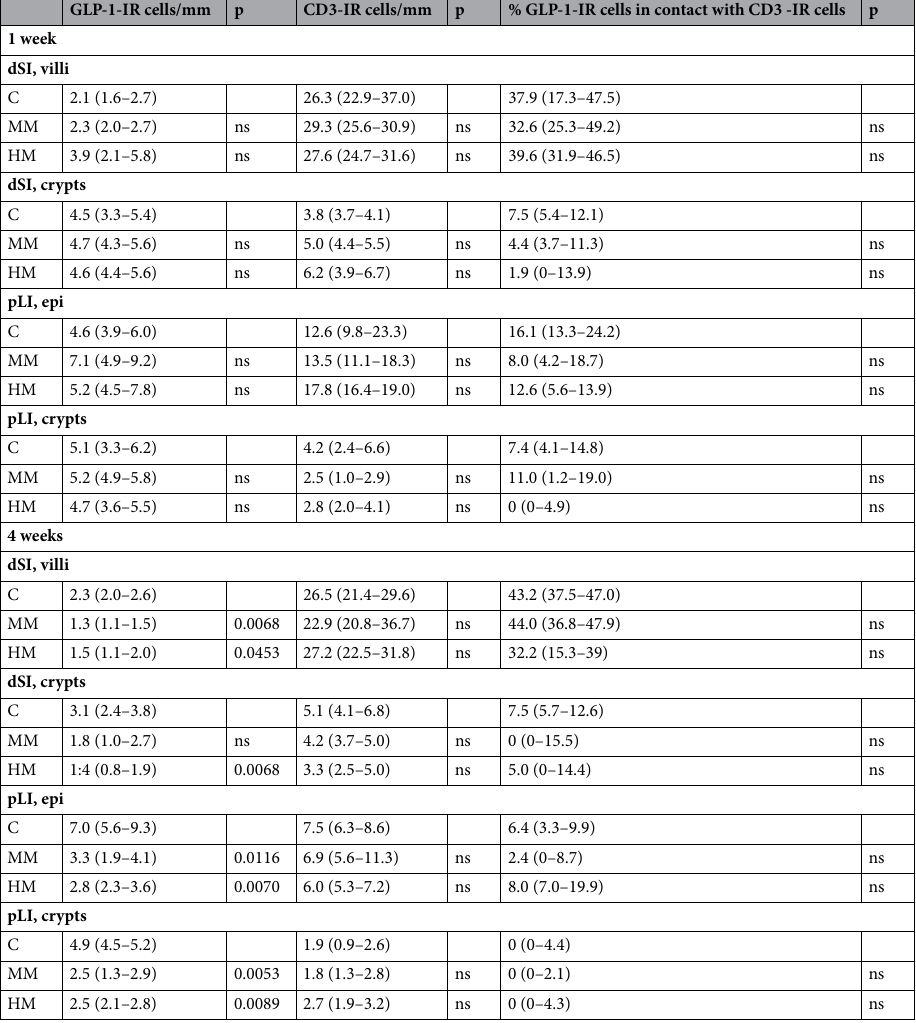
Raised against Code no